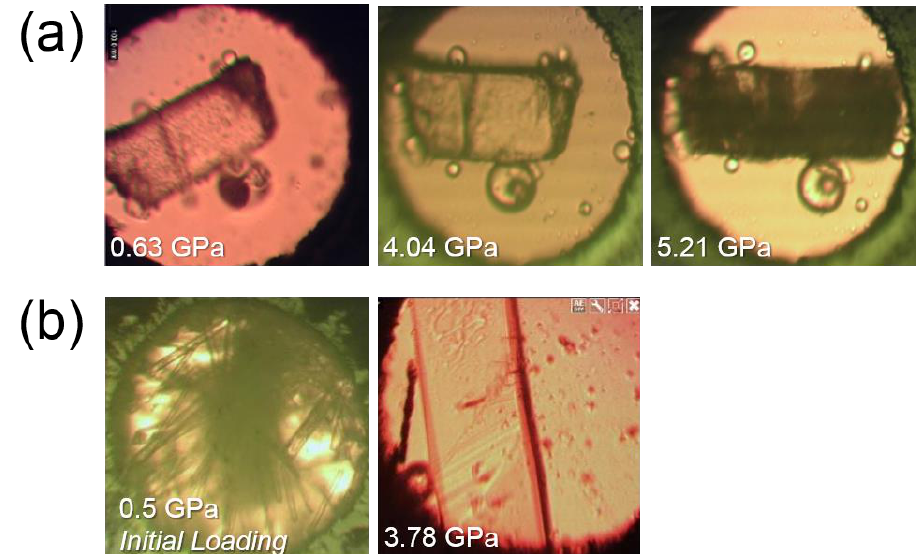
Figure 8. Crystals used in this study: ( a ) Ex situ crystal loaded in methanol-ethanol (Section 4.2i), the crystal transparency reduction is apparent at 5.21 GPa. ( b ) In situ crystal growth from melting the initial polycrystalline mass to 420 K and allowing to cool to room temperature repeatedly (Section 4.2iii).